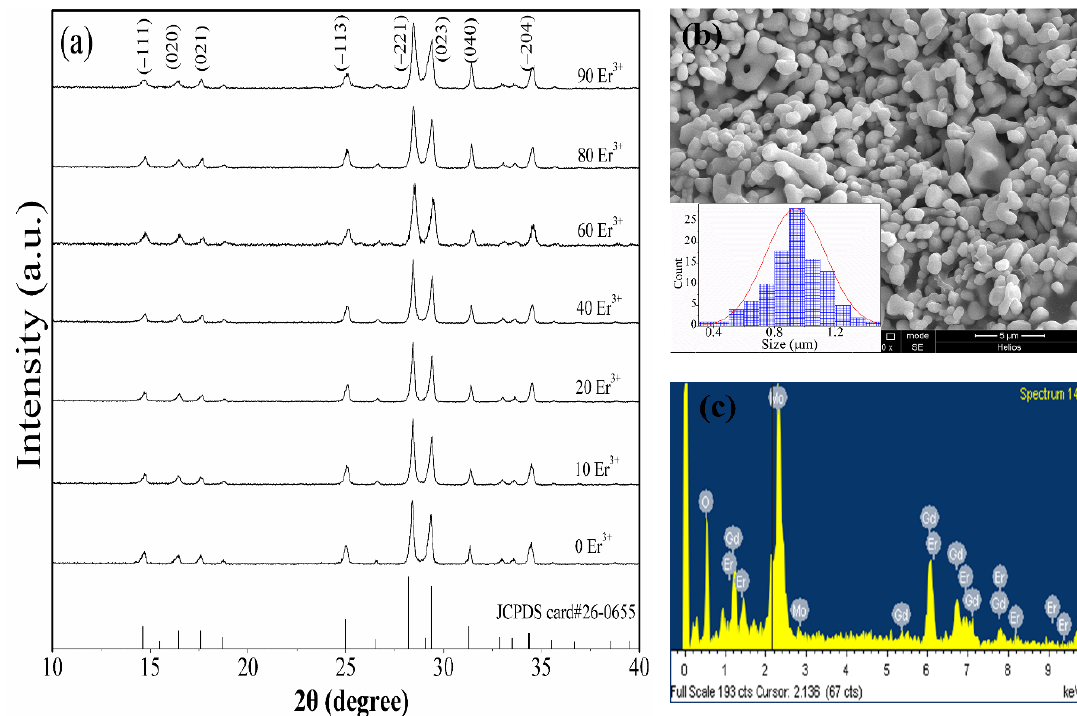
Figure 1. XRD patterns of Gd 2 (MoO 4 ) 3 : x Er 3+ ( x = 0, 10, 20, 40, 60, 80, 90 mol%) phosphors ( a ). SEM image ( b ) and EDS spectrum ( c ) of Gd 2 (MoO 4 ) 3 :20Er 3+ phosphor. The inset of ( b ) shows the particle size distribution.